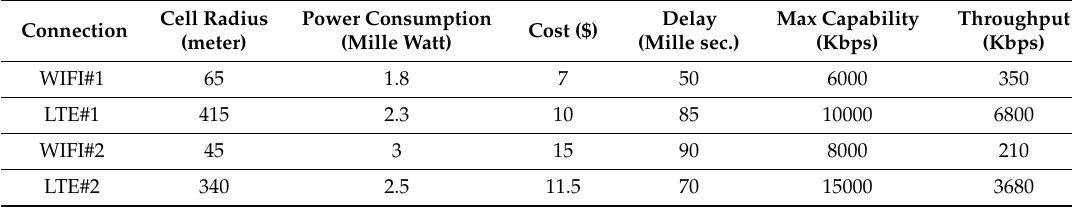
Table 3. Characteristics of alternative connections.